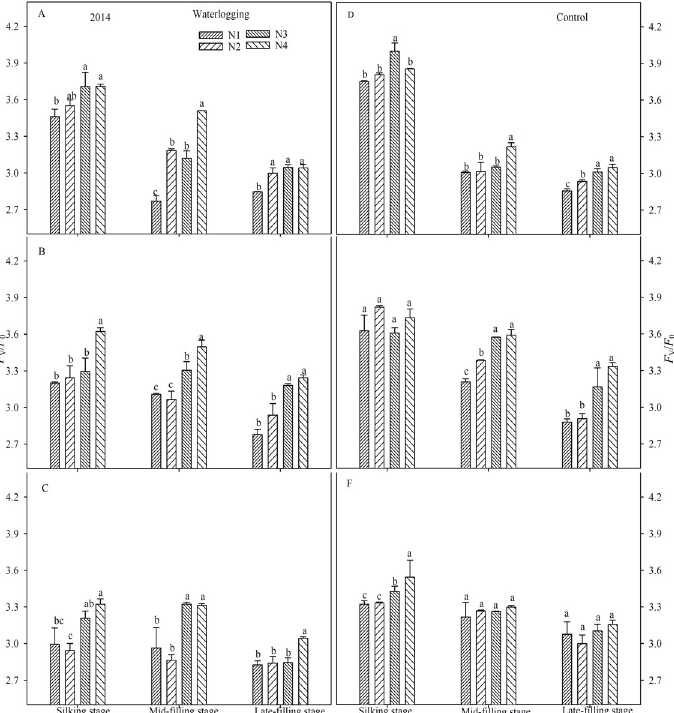
Fig 5. Potential efficiency of PSII ( F v / F 0 ) in different leaf layers under different N treatments (2014). The error bars represent the standard errors of the mean. Different letters above the bars indicate significant differences ( p < 0.05) among the different N treatments. A,D: above-ear leaves; B,E: ear leaves; C,F: below-ear leaves. N1: 100% N applied as basal fertilizer, N2: 70% N applied as basal fertilizer and 30% N applied at the jointing stage, N3: 50% N applied as basal fertilizer and 50% N applied at the jointing stage, N4: 30% N applied as basal fertilizer, 50% N applied at the jointing stage and 20% N applied at the big flare stage.